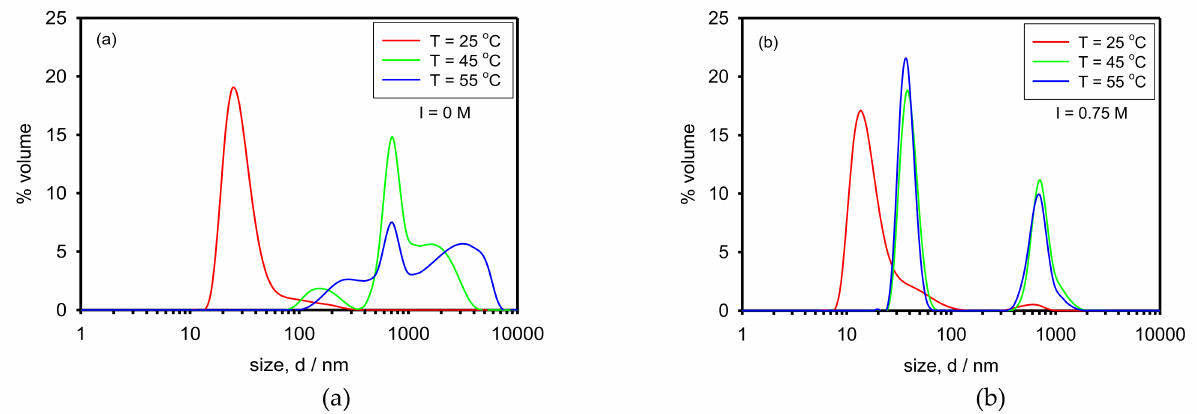
Figure 8. Size distribution by volume of the nanocomposite (AuNPs + Cop-48/6) at several temperatures. ( a ) Without added salt, and ( b ) with NaCl concentration 0.75